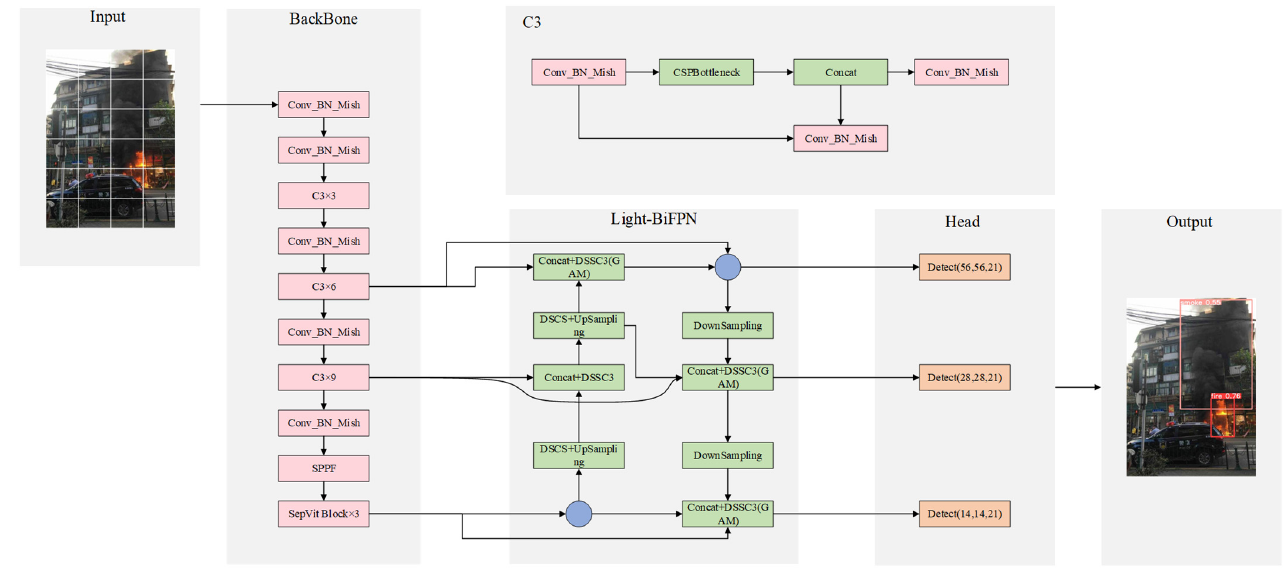
Figure 1. The architecture of the Light-YOLOv5 model.